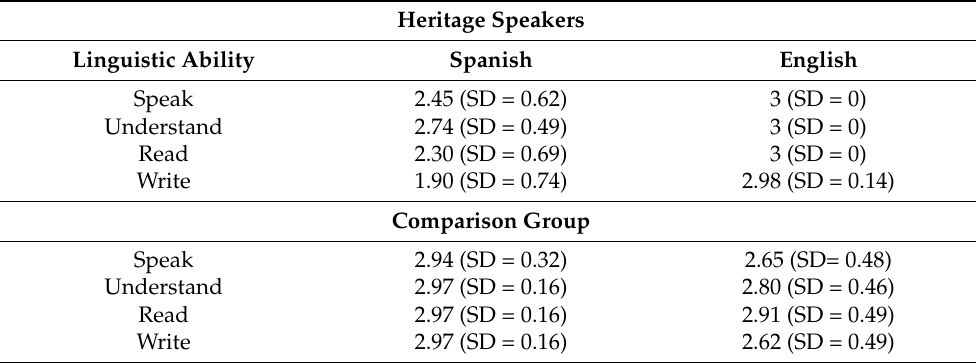
Table 1. Self-reported proficiency in English and